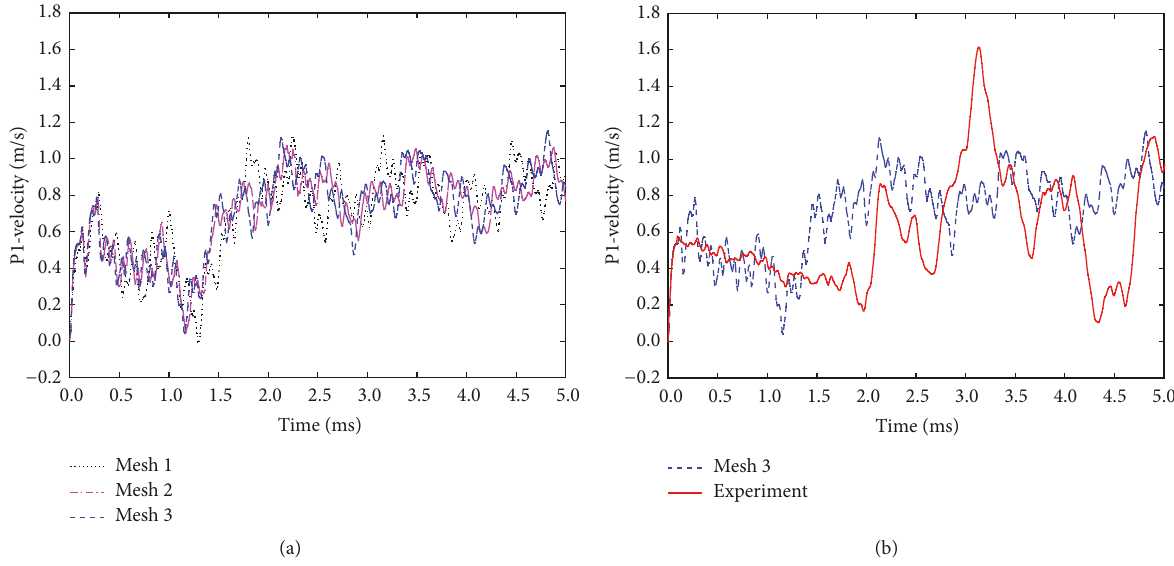
Figure 7: Velocity of point P1: (a) simulation results with mesh refinements in contact region; (b) comparison between simulation using mesh 3 and experiment.